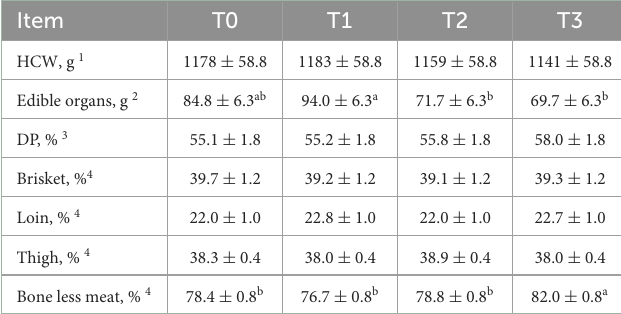
parameters in the different groups studied.